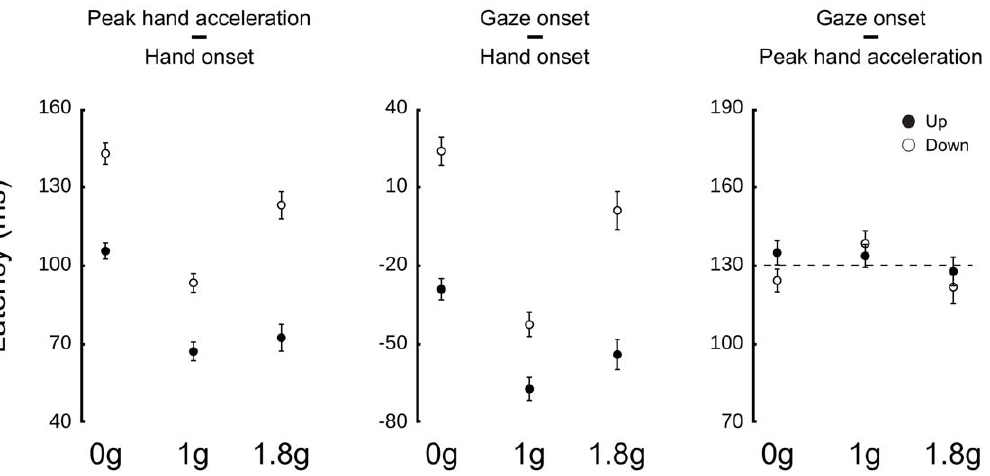
Figure 5. Constant latency across direction and gravitational conditions between times of peak hand acceleration and gaze saccade onset to the target. Relative latencies between peak hand acceleration and hand onset (left panel), gaze onset and hand onset (middle panel) and between gaze onset and peak hand acceleration (right panel) in the three gravity fields. Open and closed disks denote downward and upward trials, respectively. Error bars represent between participants SE. The horizontal dashed line in the right panel is positioned at mean latency (132.6 ms).